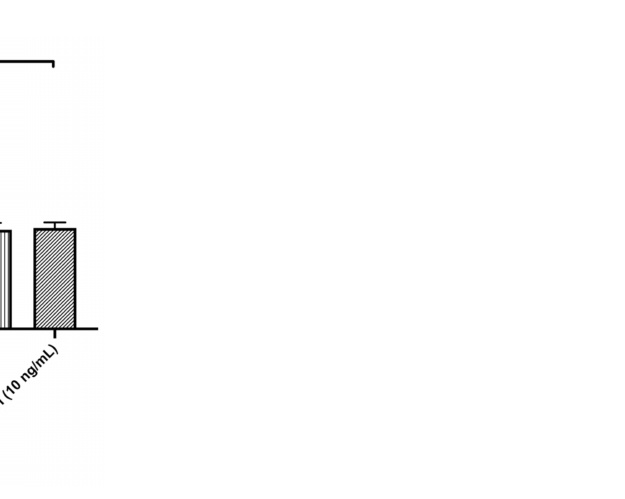
Figure 2. The effects of α -MSH on ESM-mediated apoptosis in macrophages. The RAW264.7 macrophages were treated with the eyecup ESMs with the addition of α -MSH (1, 3, or 10 ng/mL) (EV + α -MSH) or with no α -MSH (ESMs). In addition, cultures of macrophages in media (Media) were used as a background control. The cells were assayed after 24 h of incubation for caspase 3/7 activity. Presented is the relative fluorescence (caspase 3/7 activity) to the background media of untreated macrophages as mean ± SEM for 7 independent experiments. NS: not significant. Statistically significant (* p ≤ 0.001) suppression of caspase 3/7 activity was seen in the cultures of the eyecup EV-treated macrophages with 3 and 10 ng/mL of α -MSH in comparison with EV-treated macrophages with no α -MSH added (EV). Treating the macrophage cells with α -MSH suppressed the activation of caspase 3/7 induced by the RPE ESMs.